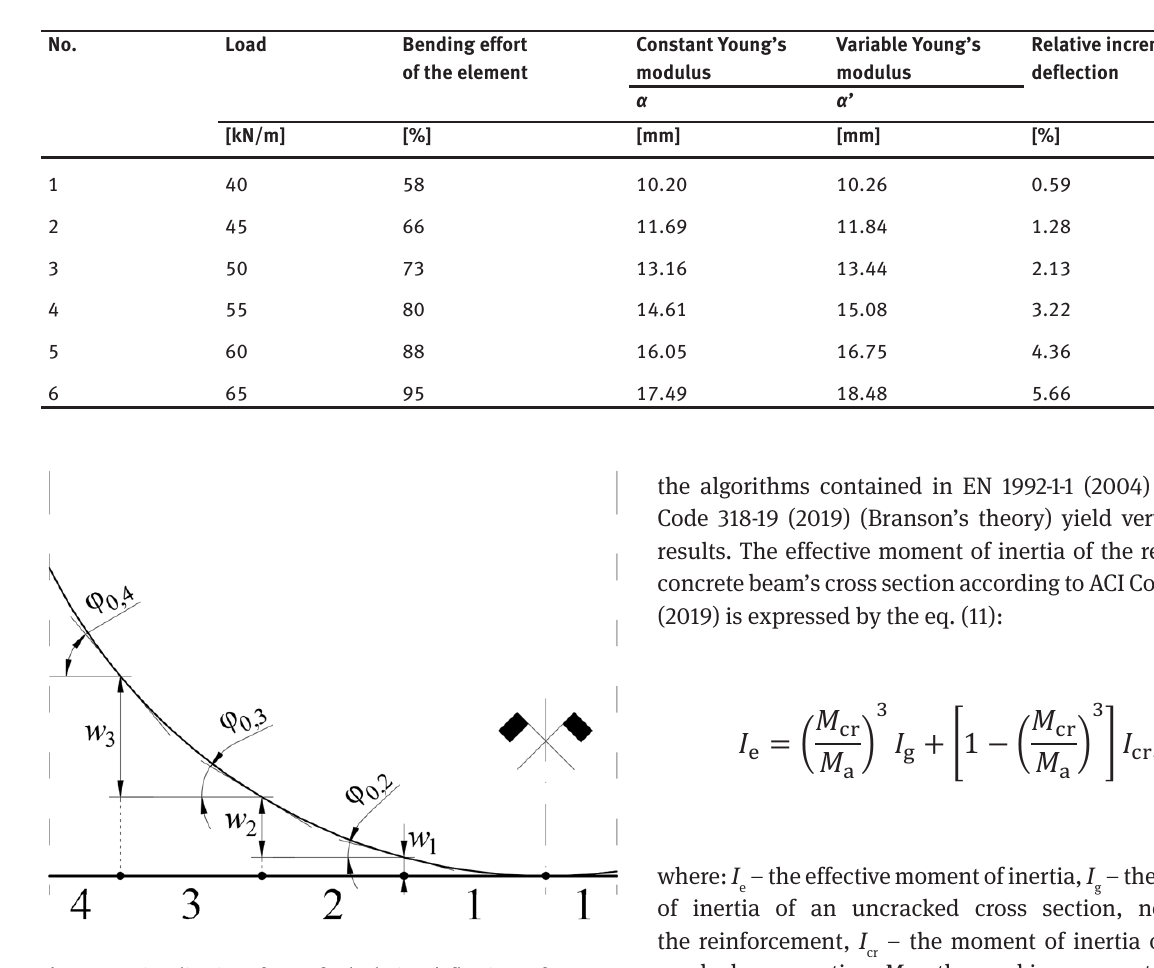
Figure 23: Visualization of way of calculating deflections of particular beam fragments.